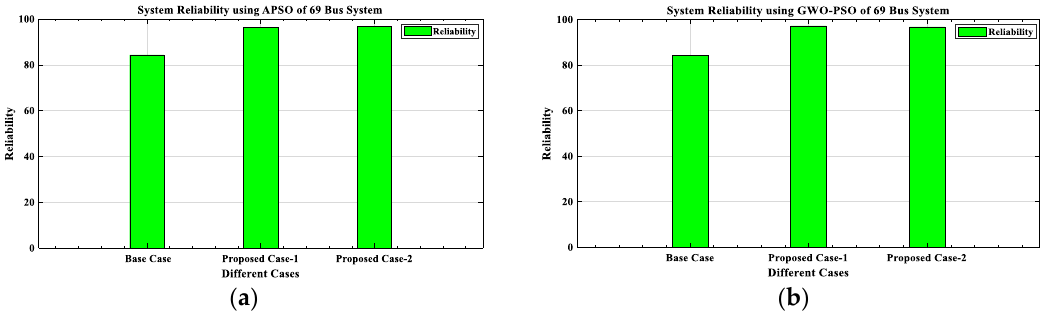
Figure 28. All proposed cases percentage reliability of the 69-bus RDN; ( a ) APSO, ( b ) GWO-PSO.